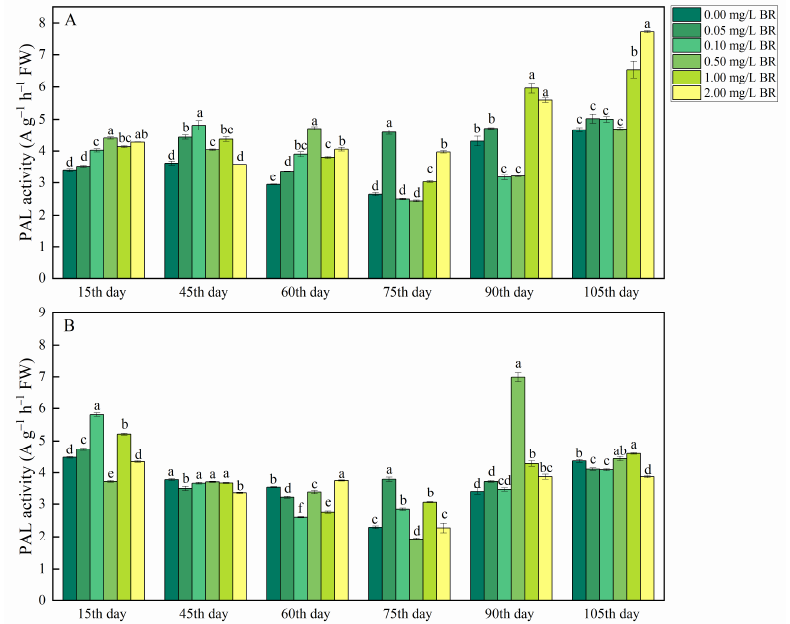
Figure 4. The change in PAL activity in tubers ( A ) and bulbils ( B ) of P. ternata at different stages after BR treatments. The bars with different letters are significantly different from each other at the same stage after BR treatments ( p < 0.05). Values are means of four replicates ± SE. GS activity in the tubers of P . ternata was enhanced by 7.18, 5.35, and 21.33% on the 15th, 60th, and 105th day after 0.10 mg/L BR treatments, and was increased by 13.42%